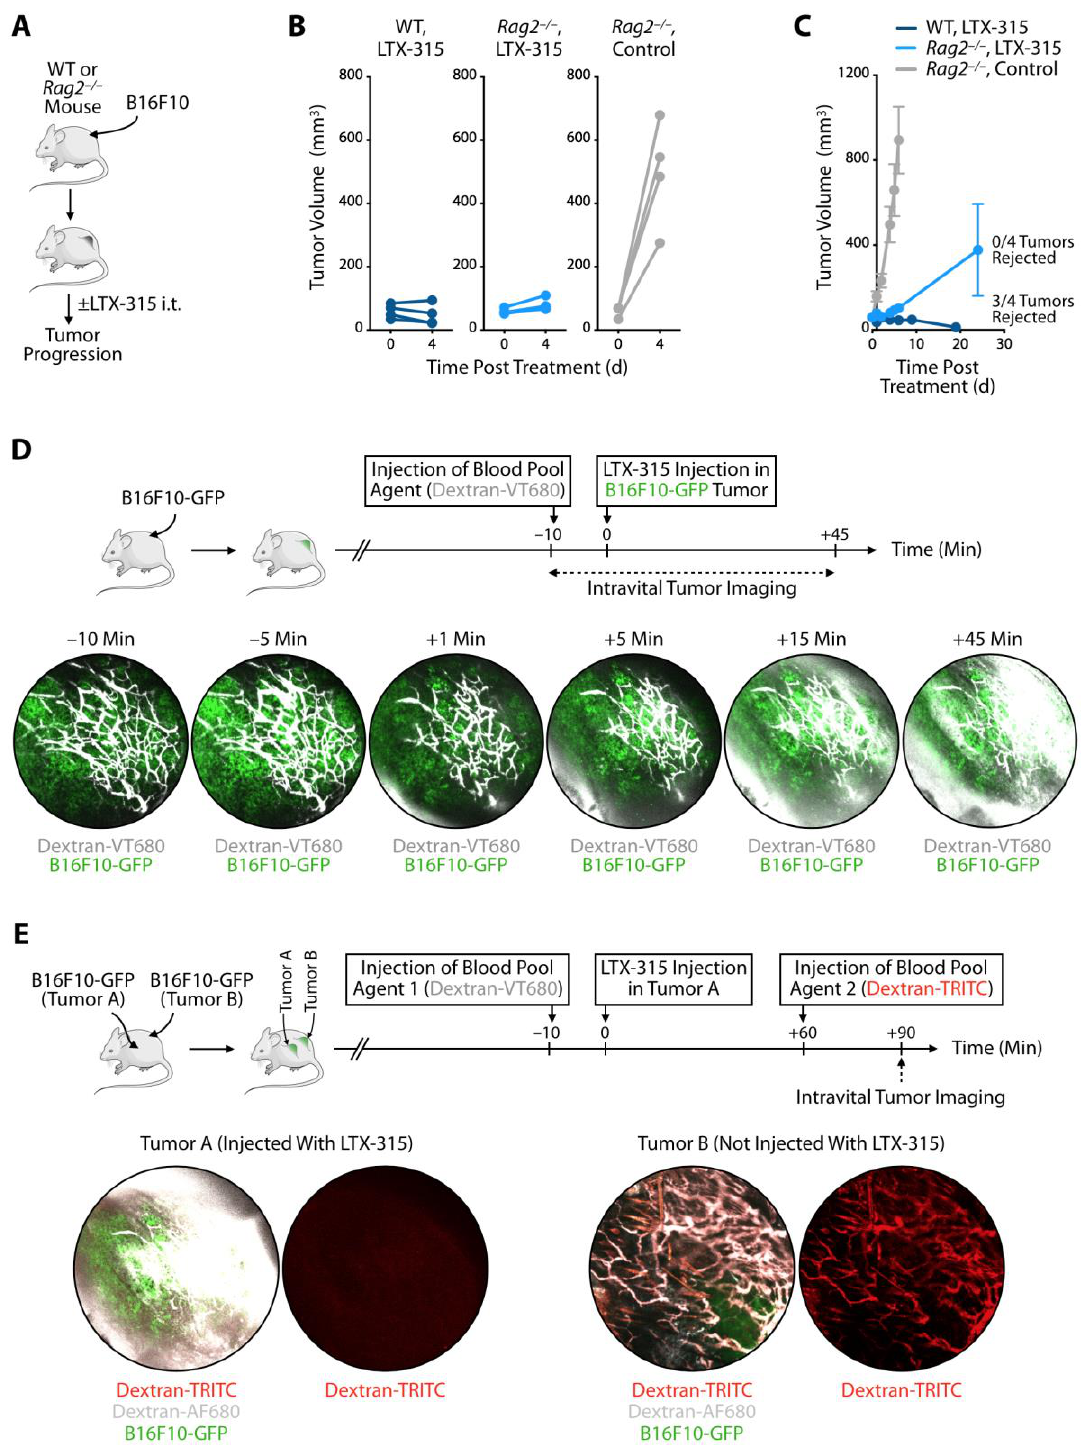
FIGURE 2: LTX- 315’s initial phase of antitumor response is defined by rapid disruption of the tumor vasculature and occurs independently of lym- phocytes. (A) Schematic of B16F10 melanoma experiments: Rag2 – / – or control wild type (WT) mice bearing B16F10 melanoma tumor grafts were ei- ther treated intratumorally (i.t.) with LTX-315 or left untreated. (B) B16F10 tumor volumes immediately before (d0) and four days after LTX-315 treat- ment (d4) in individual WT mice (dark blue) and Rag2 – / – mice (light blue). Untreated Rag2 – / – mice (grey) were used as controls; n = 4 mice/group. (C) Cumulative B16F10 tumor volumes over time of mice treated as in (B). (D) Intravital microscopy of a vasculature agent (Dextran-VT680, white) at dif- ferent time points before and after intratumoral LTX-315 injection in mice bearing B16F10-GFP melanoma tumors (green). (E) Intravital microscopy of two vasculature agents (Dextran-VT680, white; Dextran-TRITC, red) in mice bearing two B16F10-GFP melanoma tumors (Tumors A and B) and after intratumoral LTX-315 injection in Tumor A only. Dextran-VT680 was injected 10 min before LTX-315 administration, whereas Dextran-TRITC was given 60 min later. Abbreviations are as follows: d =